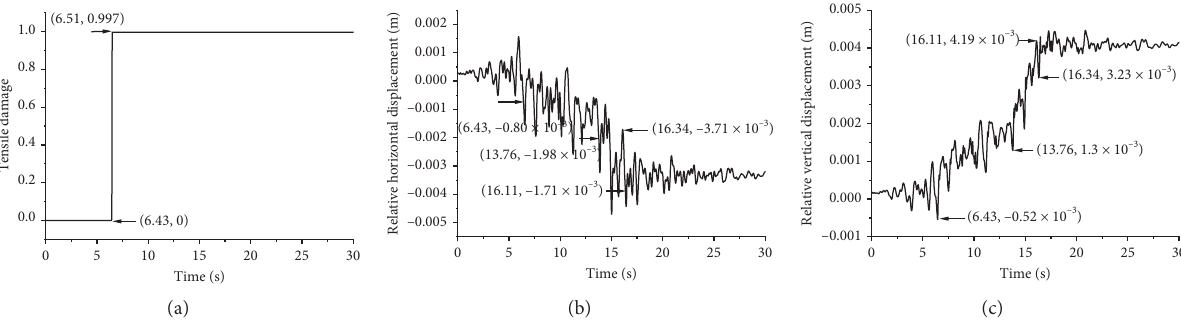
Figure 11: Time histories of relevant variables at the element 3143 for the earthquake overload coefficient of 1.53. (a) Time history of tensile damage variables. (b) The relative horizontal displacement is 3.20mm after the earthquake. (c) The relative vertical displacement is 4.15mm after the earthquake.